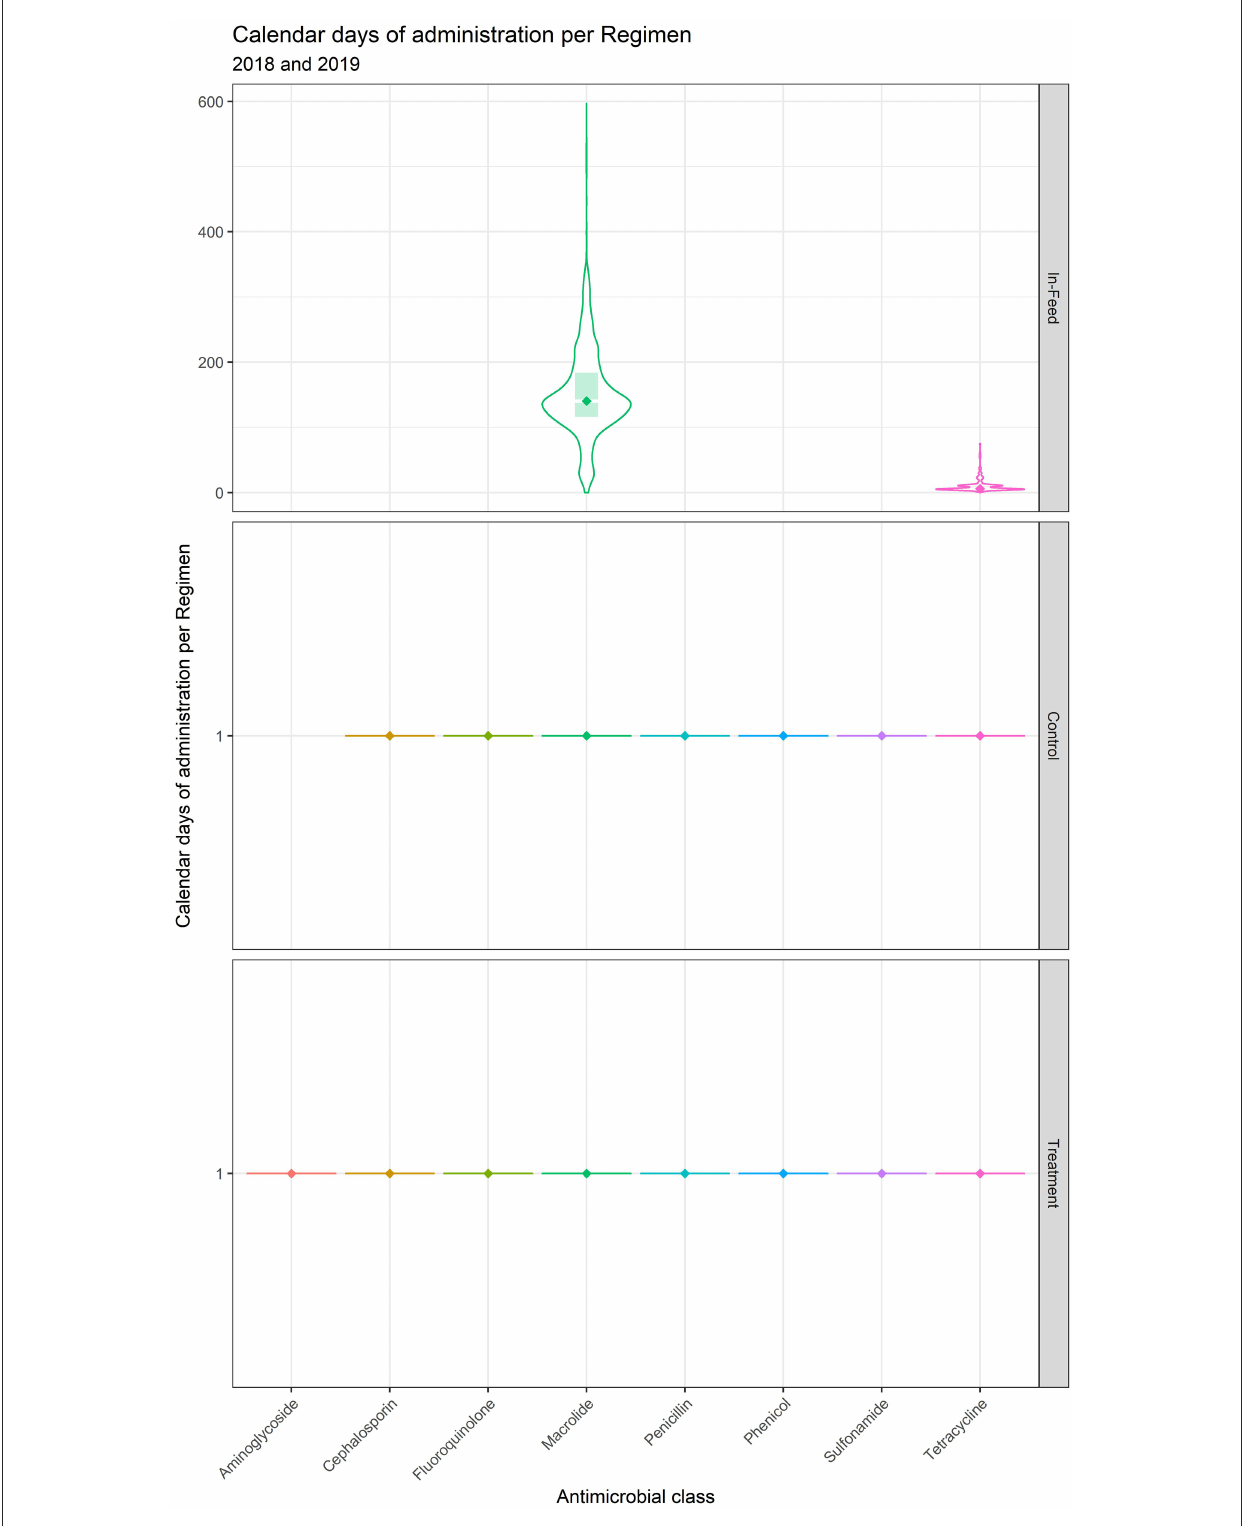
FIGURE2 Calendar days of administration per regimen for medically important